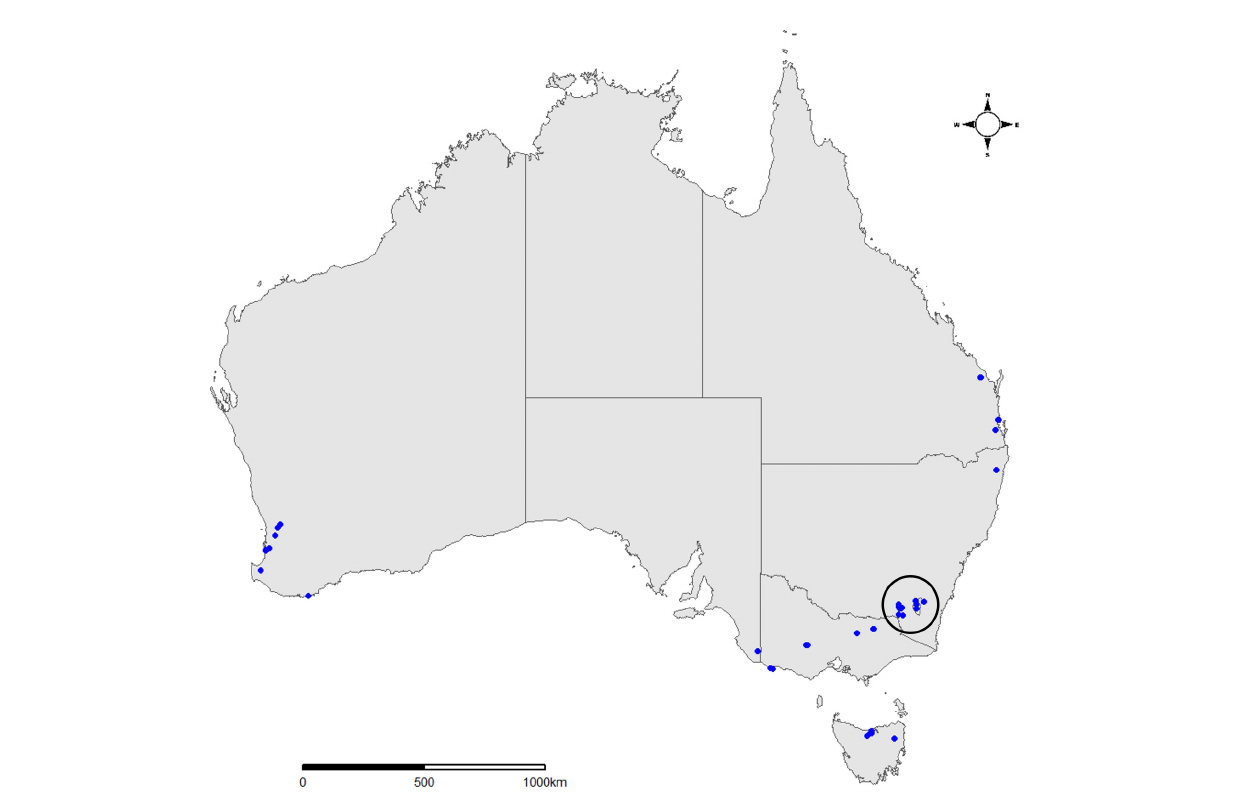
FIGURE1 Map of Australia showing 45 sampling locations across seven states and territories from which trap samples were collected during the current study. Samples encircled from the Central Tablelands represent a 15-trap subset used to evaluate sample processing and barcode amplification from forestry surveillance traps. This figure was produced in R using the ggplot2, ggmap, ozmaps and ggsn R packages (Kahle and Wickham, 2013; Wickham, 2016; Sumner,